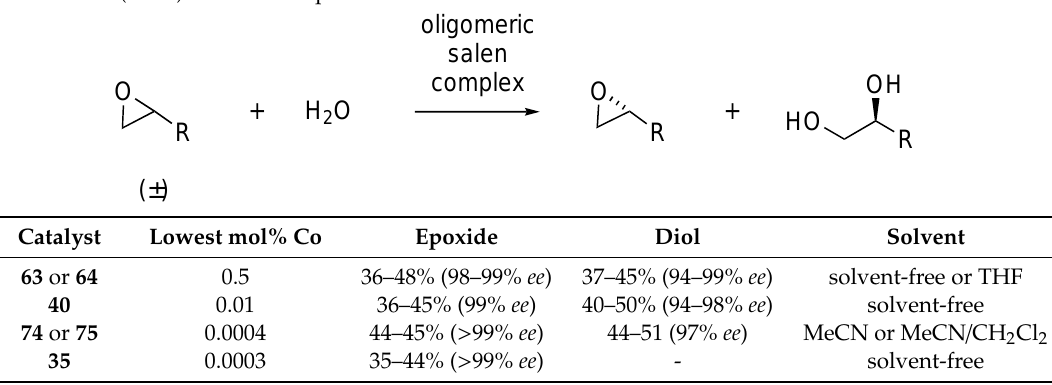
Figure 30. Jacobsen and coworkers’ [115] second generation of oligosalen catalysts 74 and 75 .